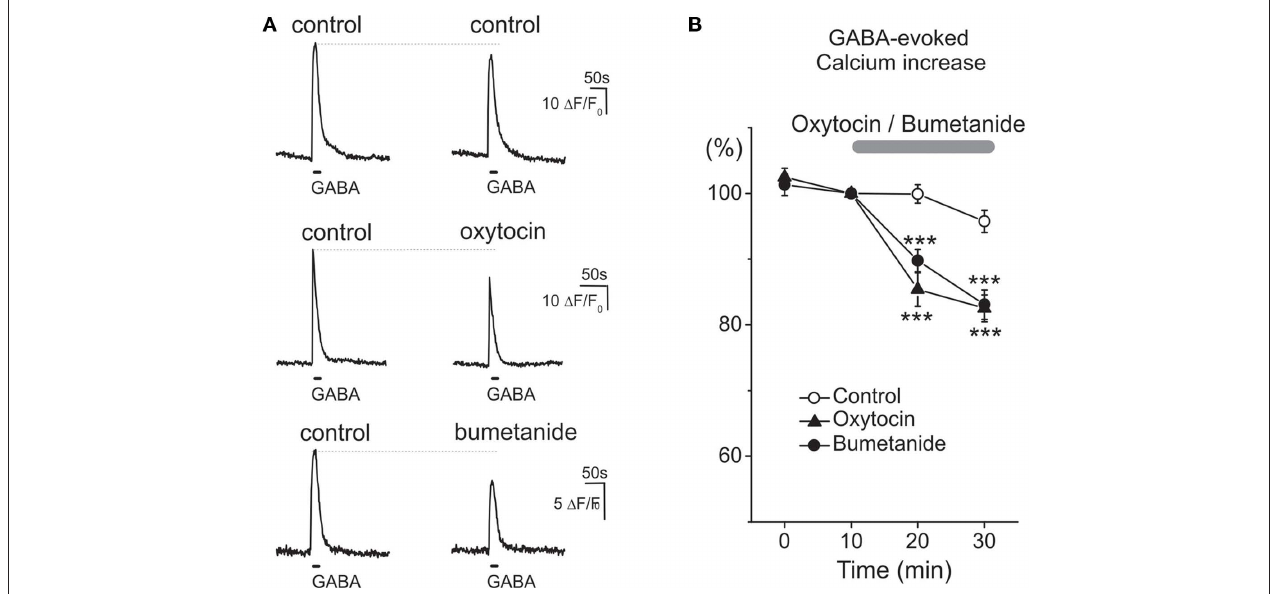
oxytocin (middle traces) and 10 µM bumetanide (bottom traces). (B) Summary plot shows the time course of changes in the normalized amplitude of GABA-induced Ca 2 + transients in control conditions ( n = 56 cells), and during application of oxytocin ( n = 31 cells) and bumetanide ( n = 15